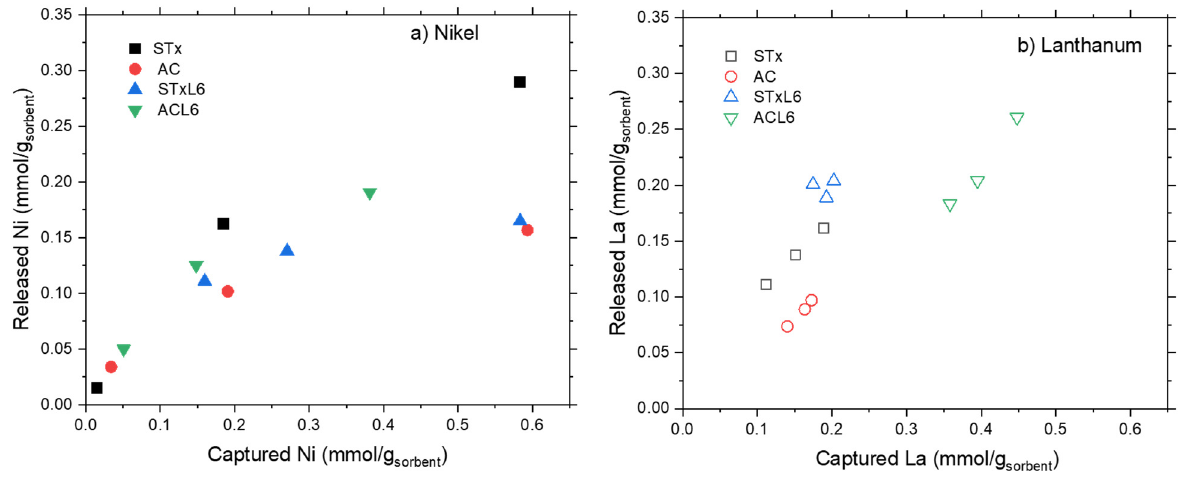
Figure 10. Comparison of metal release for the four sorbents. Table 4. Comparison of metal release percentages as a function of the absolute capture values for the four different sorbent